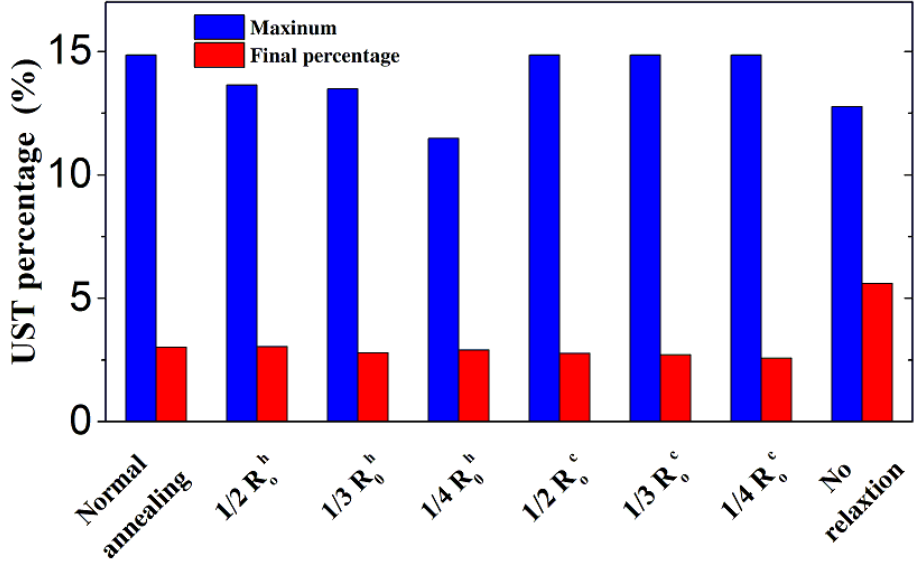
Figure 5. The maximum and final percentage of UST (unidentified structure-type) atoms at the temperature of 4000 K for various heating/cooling rates. R h o is the original heating rate. R c o is the original cooling